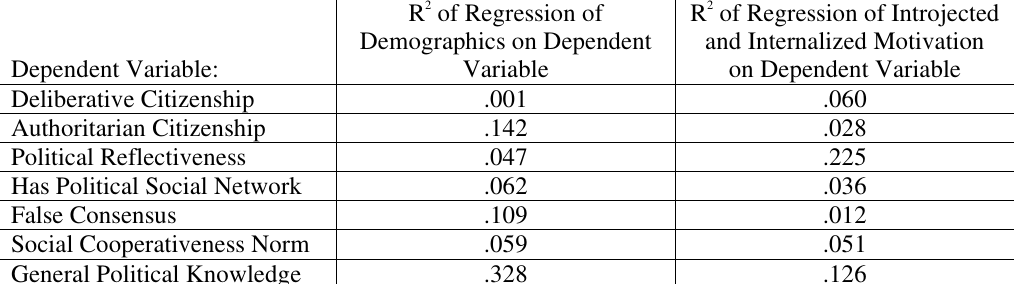
Table 3: Demographic and Motivational Underpinnings of Factors Influencing Decision